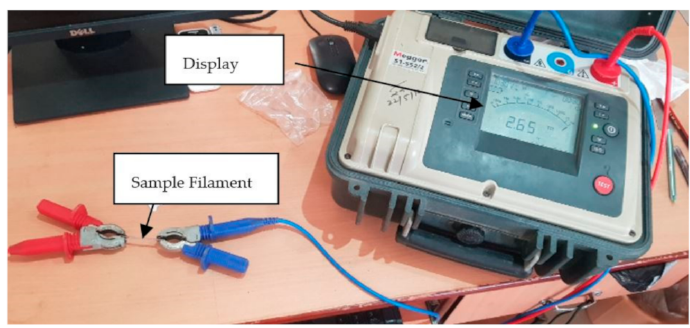
Figure 5. Electrical resistivity testing apparatus.